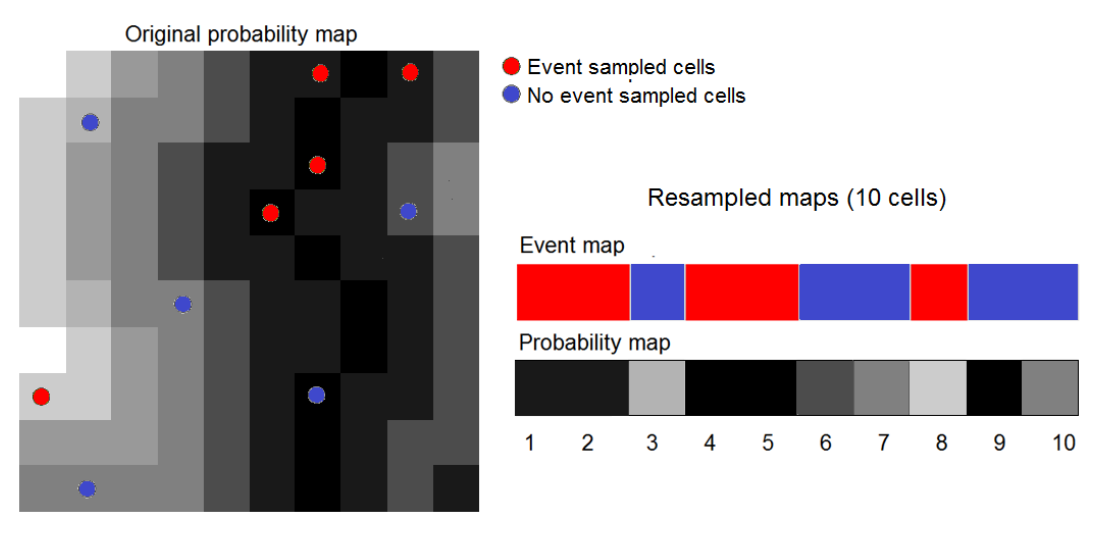
Figure 4. Sampling procedure. Original image is read line by line and selected cells are sorted into a one-line resampled